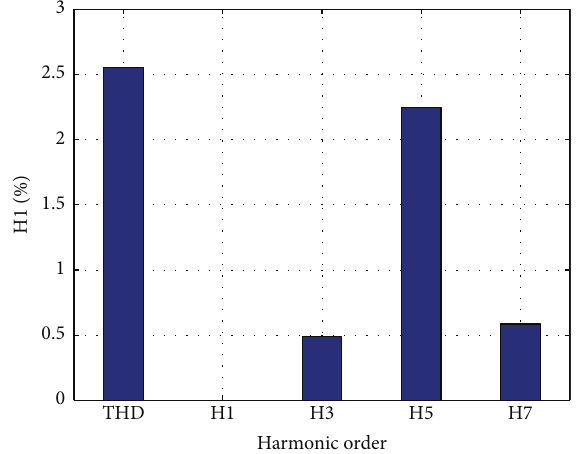
Figure 6: Total harmonic distortions registered during the day in the first facility.